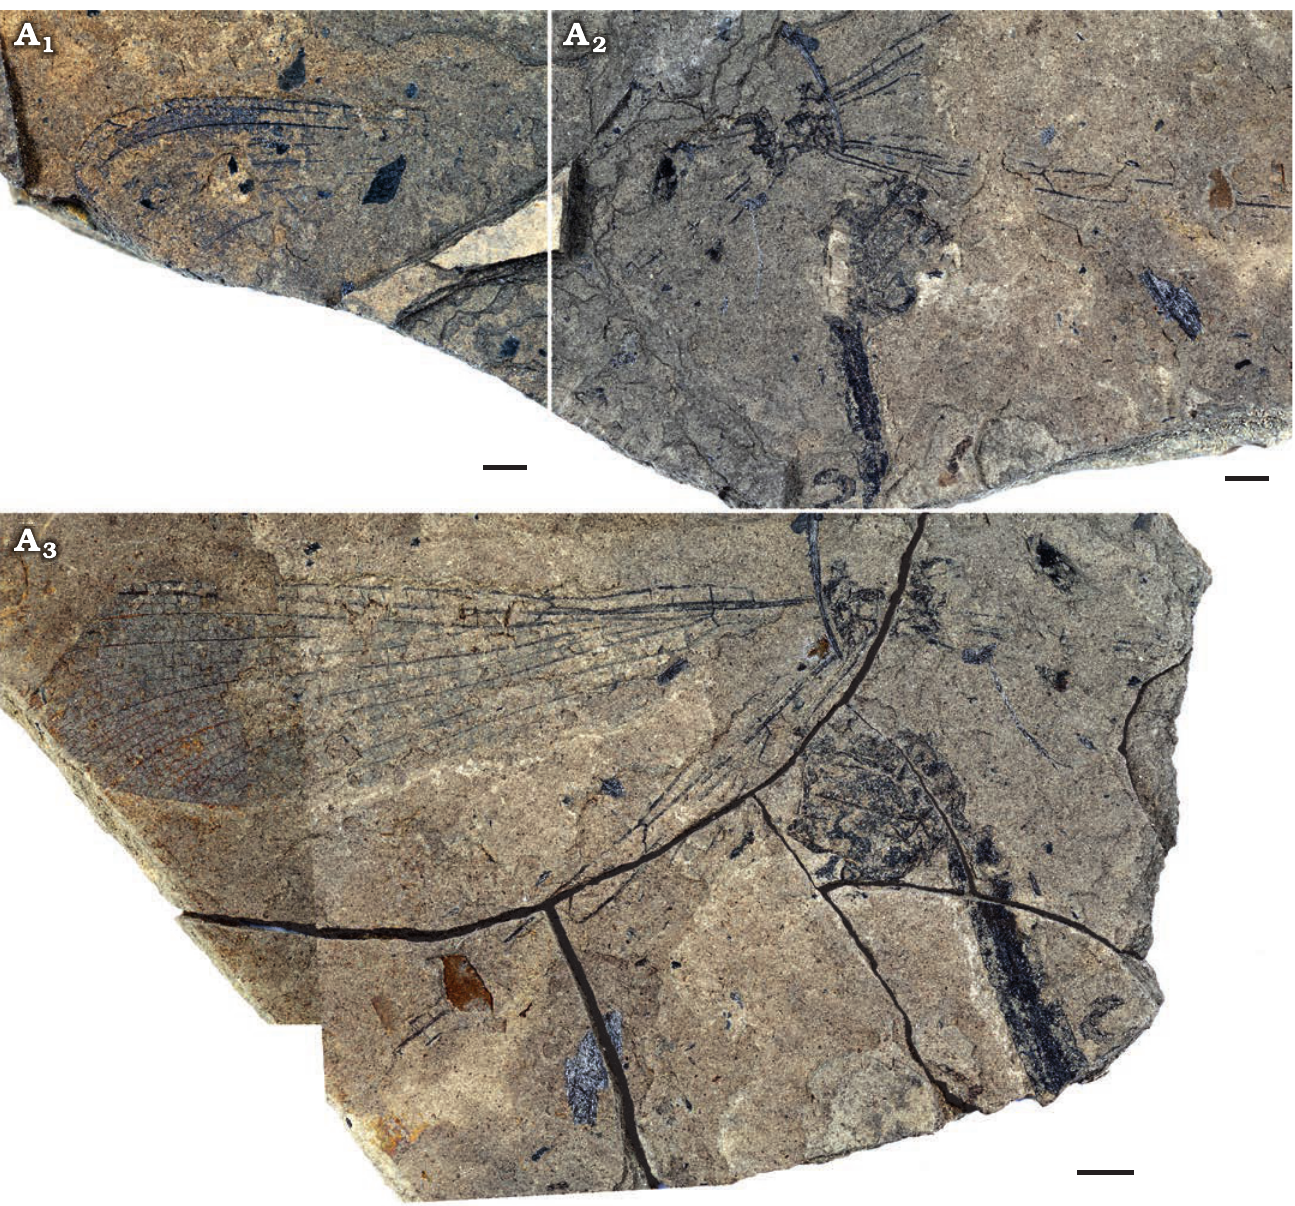
terimprint (A 3 ). Scale bars 1